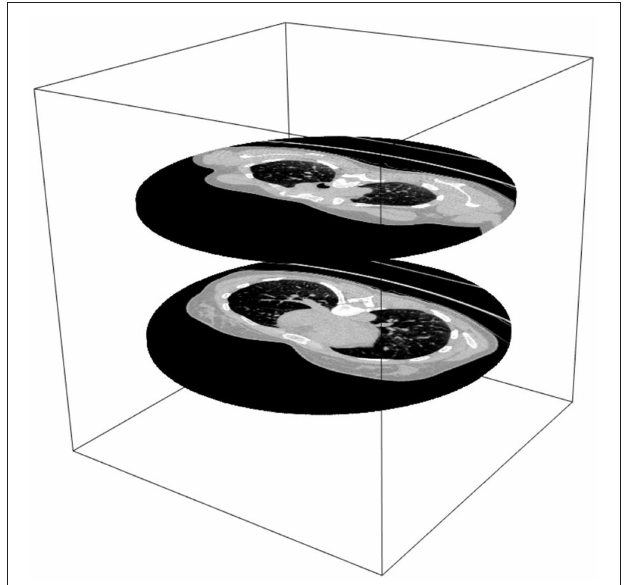
FIGURE 1 | CT scan images from the SCANN’AIR study. Data are two thoracic slices: one from the upper lung and the other from the lower